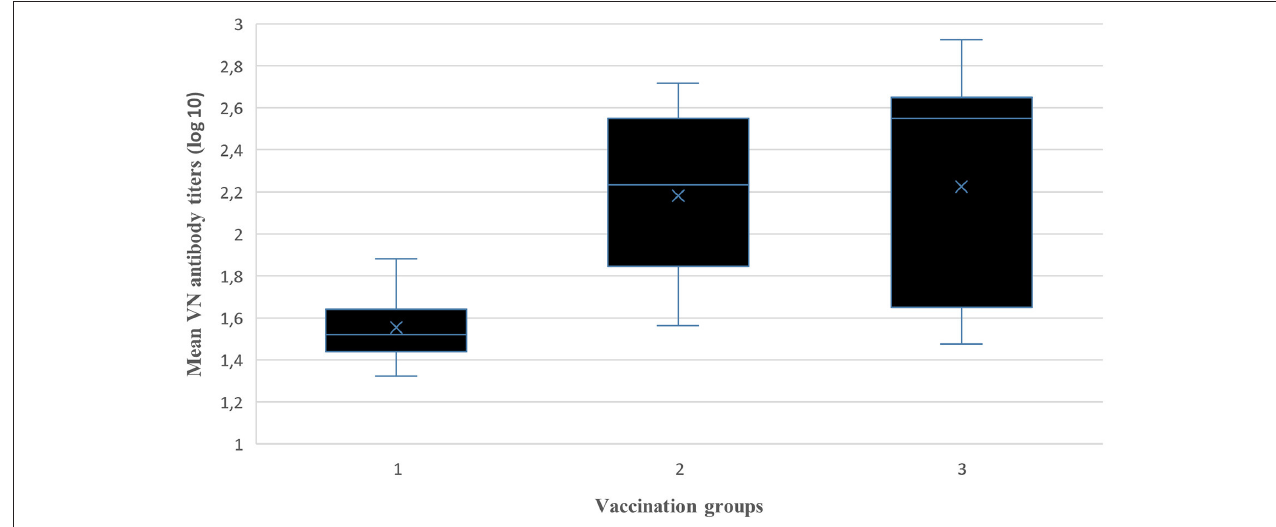
FIGURE 4 | Comparison between vaccination groups of the mean log10 VN titers (independent samples Kruskal–Wallis